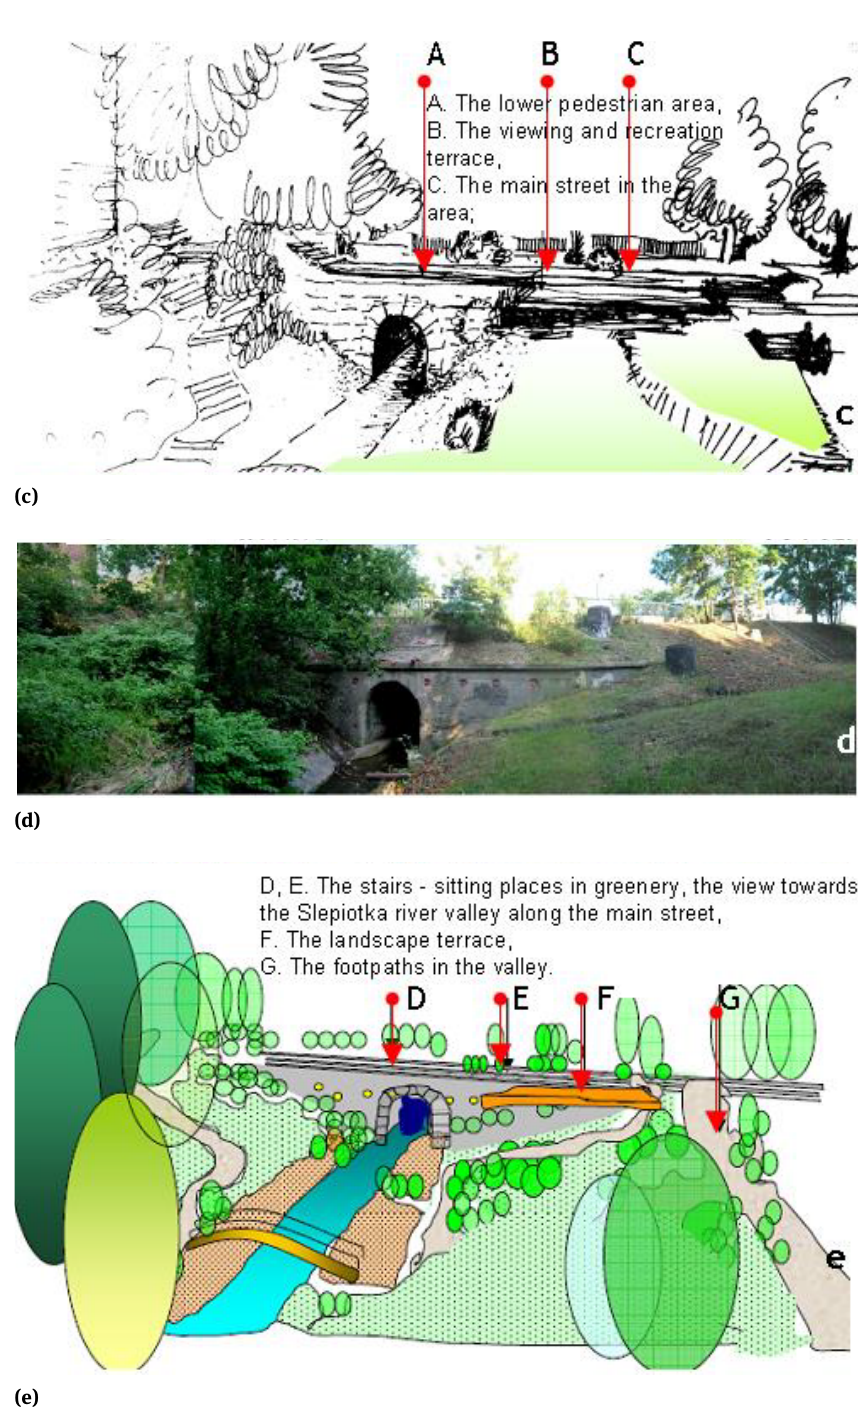
Figure 6: The photo of the existing state in 2009 (d) and the concept (c, e) of the revitalization of the Slepiotka river valley in Katowice, Poland. The project made 2009 by the Arch-Urbs Architectural and Urban Research-Design Oflce in Katowice in frames of the European REURIS Programme (Revitalization of Urban River Spaces) was realized 2010/2011. In the pictures (c, e) the suggestions of the renaturaliza- tion of natural elements in public spaces by the Slepiotka river are presented. The plants, both the original and the new ones, are the base for the idea of the the natural environment renewal in the neglected urban